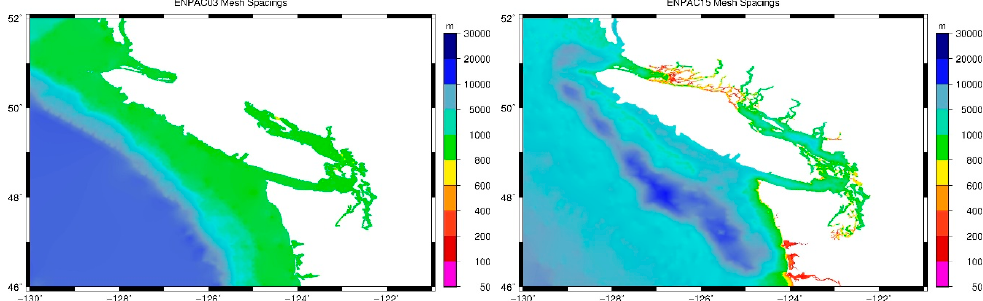
Figure 4. Comparison of coastal resolution in the ENPAC03 (left panel) and ENPAC15 (right panel) models for the Vancouver Island and Washington coast regions.